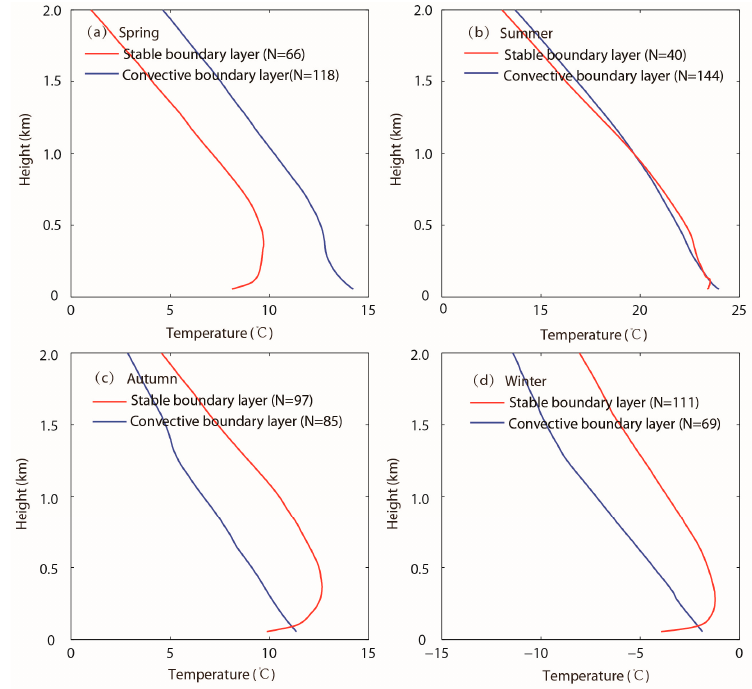
Figure 2. The average vertical temperature profiles of stable BLH and convective BLH for spring ( a ), summer ( b ), autumn ( c ) and winter ( d ).